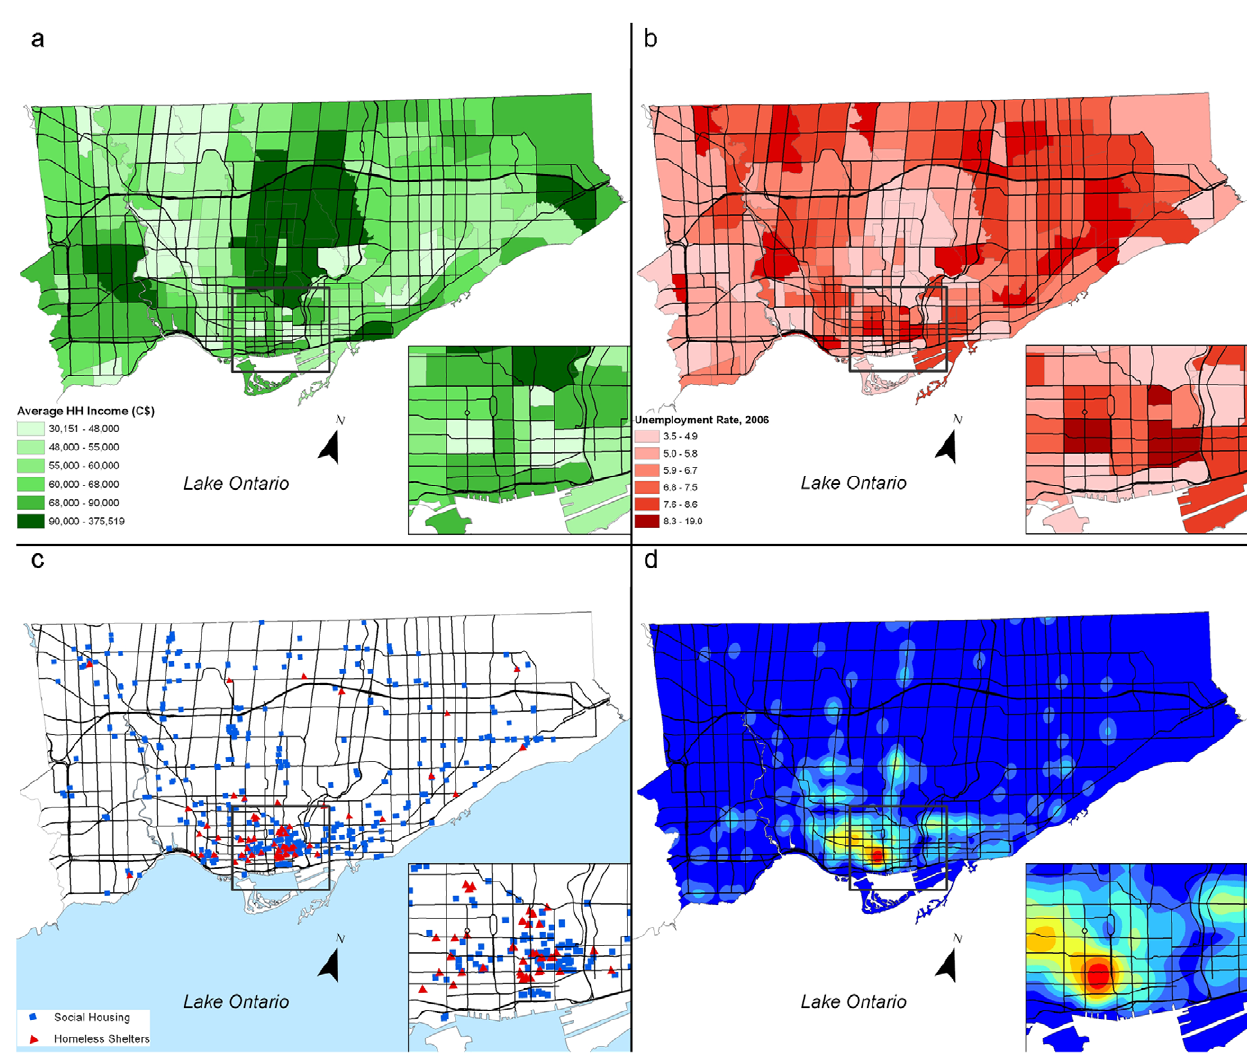
Figure 5. Land use and economic characteristics of the City of Toronto (2001 Canadian Census). Figure 5a: Mean household income. Figure 5b: Unemployment rate. Figure 5c: Social housing and homeless shelters. Figure 5d: Density of alcohol drinking